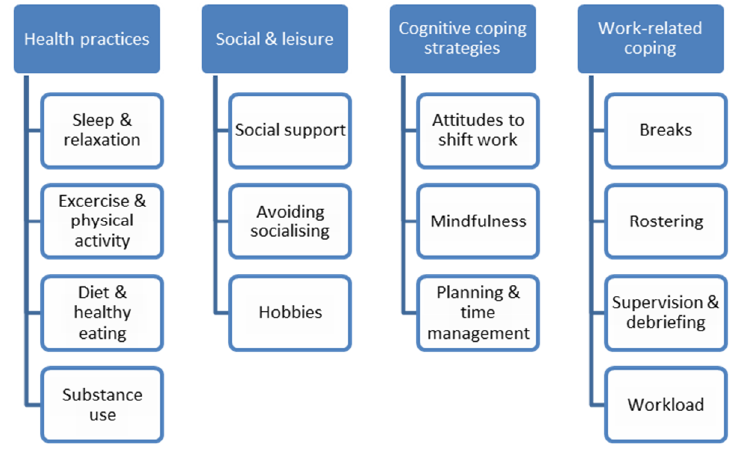
Figure 1. Themes and sub-themes identified.